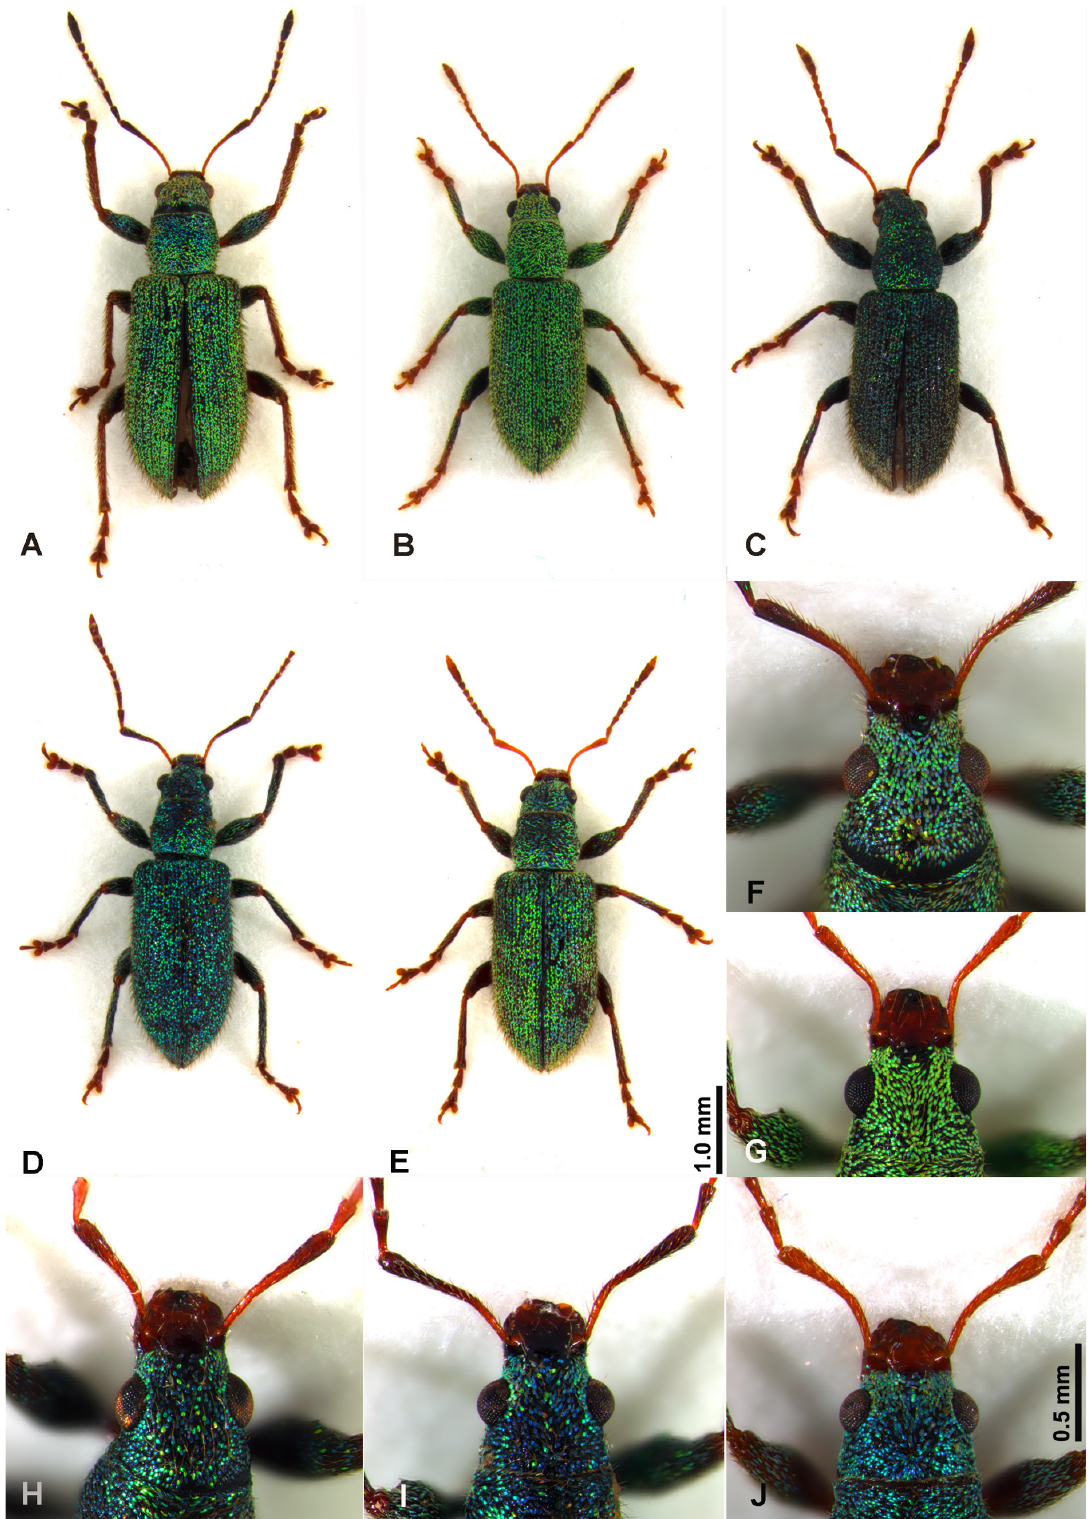
Fig. 1. A-E . Habitus. F-J . Head and antennal scape of Dichorrhinus spp., ♂. — A , F . D. alziari sp.